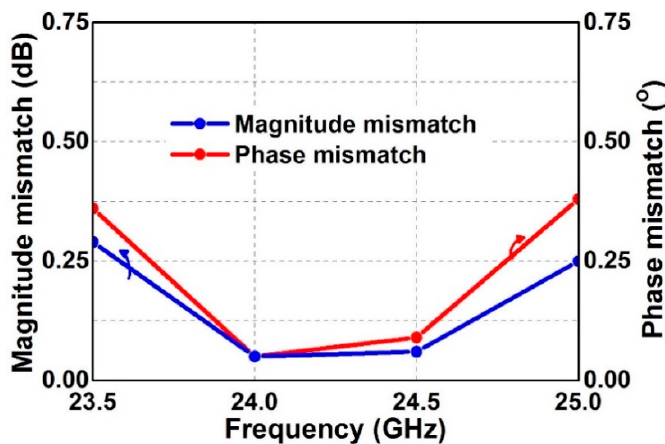
Figure 7. Layout diagram for 1st-order poly-phase filter. Electronics 2020 , 9 , x FOR PEER REVIEW